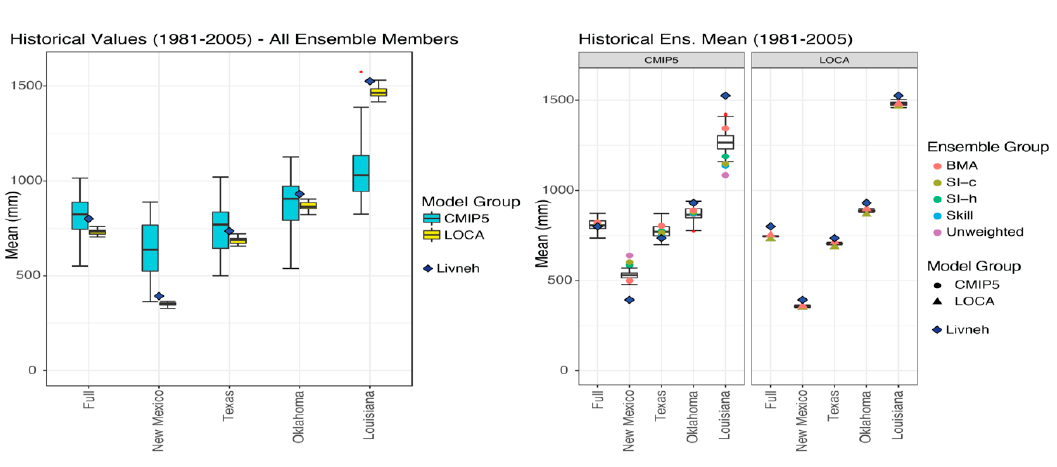
Figure 5. Left—Historical values for CMIP5 and LOCA ensembles with the Livneh observed values averaged over the full domain and subdomains. Right—Weighted ensemble mean values with Livneh observed values and boxplot of BMA simulated ensemble means averaged over the full domain and subdomains.